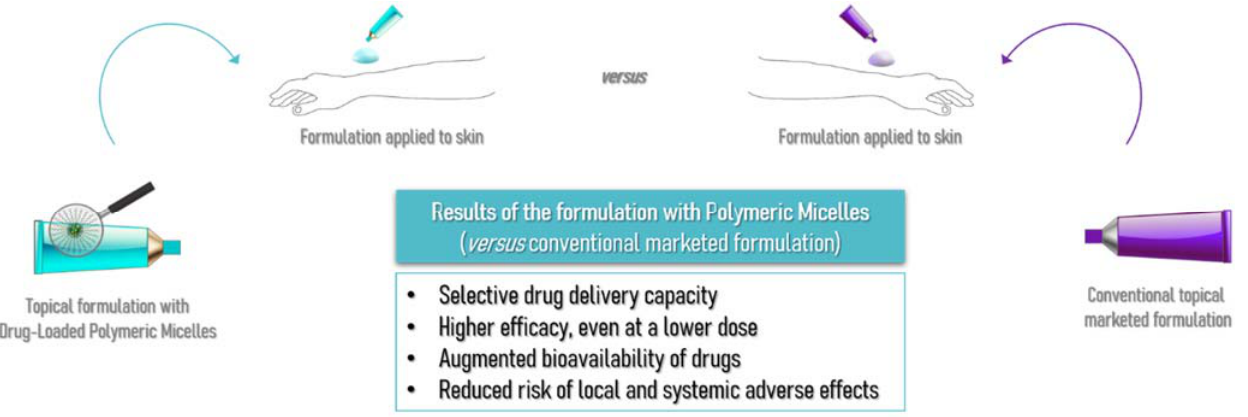
Figure 8. Schematic representation of the comparison between conventional topical marketed formulations and formulations containing polymeric micelles as drug carriers, and the results that were obtained.